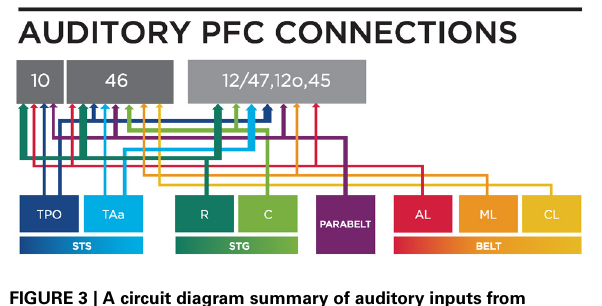
FIGURE 3 | A circuit diagram summary of auditory inputs from temporal lobe areas to the PFC, from anatomical studies (including: Petrides and Pandya, 1988; Seltzer and Pandya, 1989; Hackett et al., 1999; Romanski et al., 1999a,b) discussed in this review. Thicker lines represents stronger connections. R, Rostral; C, Caudal; STS, Superior Temporal Sulcus; STG, Superior Temporal Gyrus; AL, Antero-lateral; ML, Middle-lateral; CL, Caudal-lateral; TPO, temporal parieto-occiptal area; TAa, Temporal area.